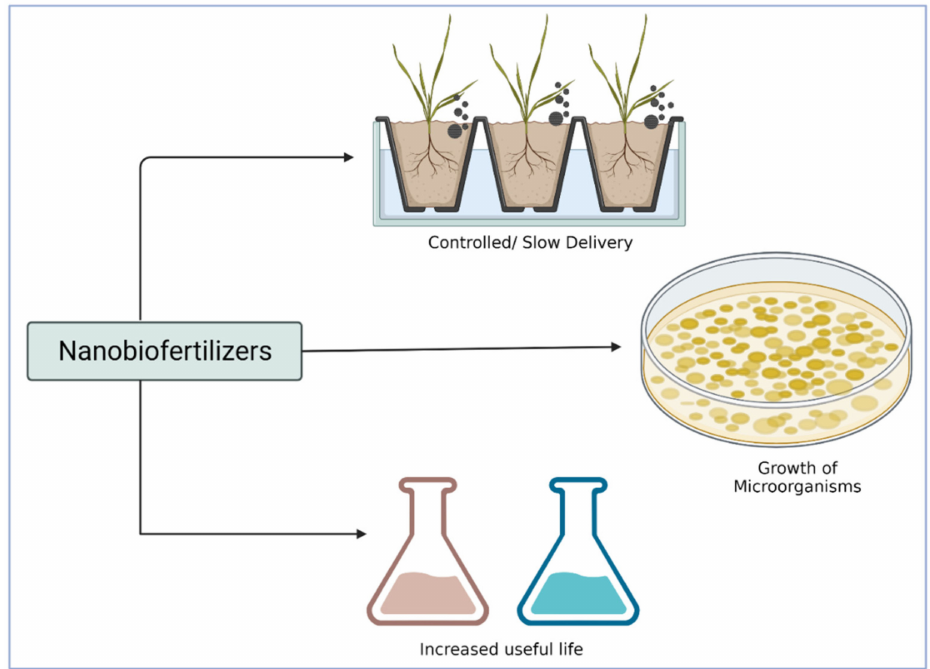
Figure 2. The functional mechanism of nanobiofertilizers in plants. An illustration depicting the major advantages of